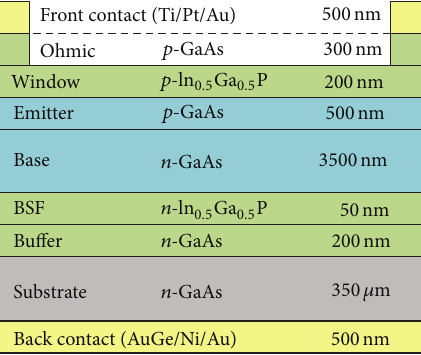
Figure1:SchematicstructureofthefabricatedGaAssingle-junction solar